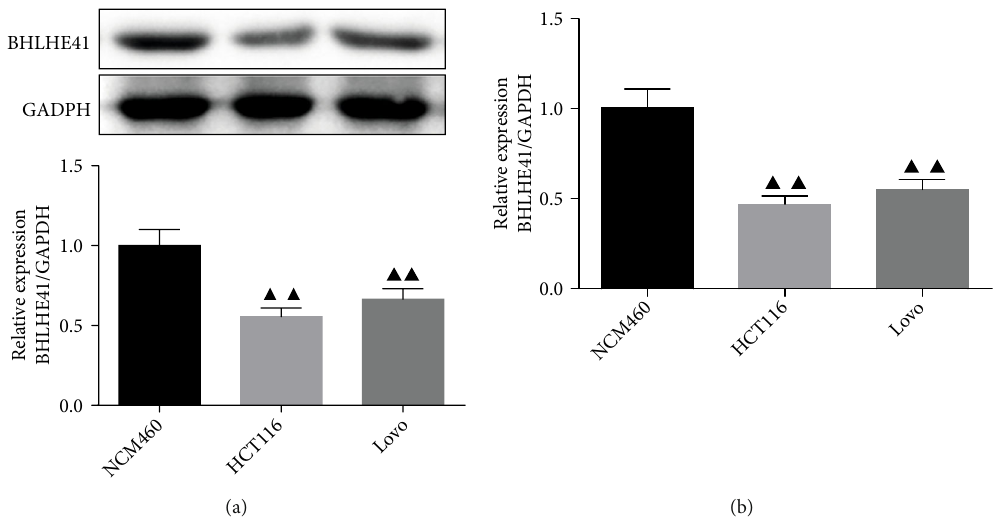
Figure 1: BHLHE41 was low expressed in HCT116 and Lovo cells. (a) and (b) The level of BHLHE41 in colon cancer (CC) cells and normal cells was tested by Western blot and qRT-PCR. All experiments have been performed in triplicate, and data were expressed as mean ± standard deviation (SD). ▲▲ P < 0 : 01 vs. NCM460.